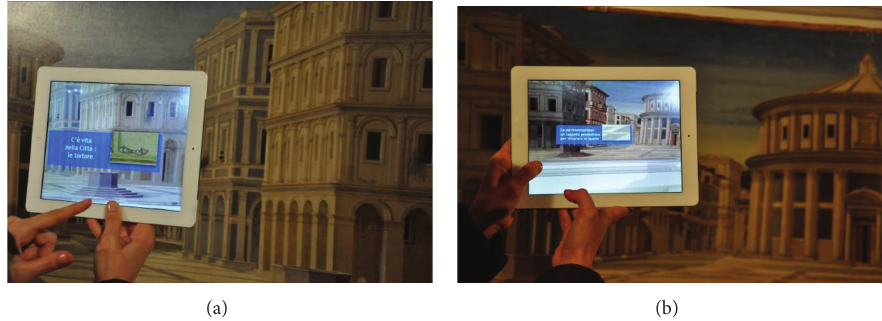
Figure 6: Virtual content visualized in real time in a real test in front of the “Citt`a Ideale” in Palazzo Ducale, Urbino, Italy.